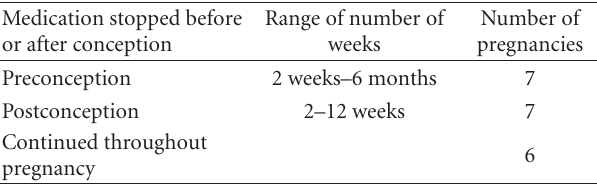
Table 4: Timing of discontinuation of stimulants.